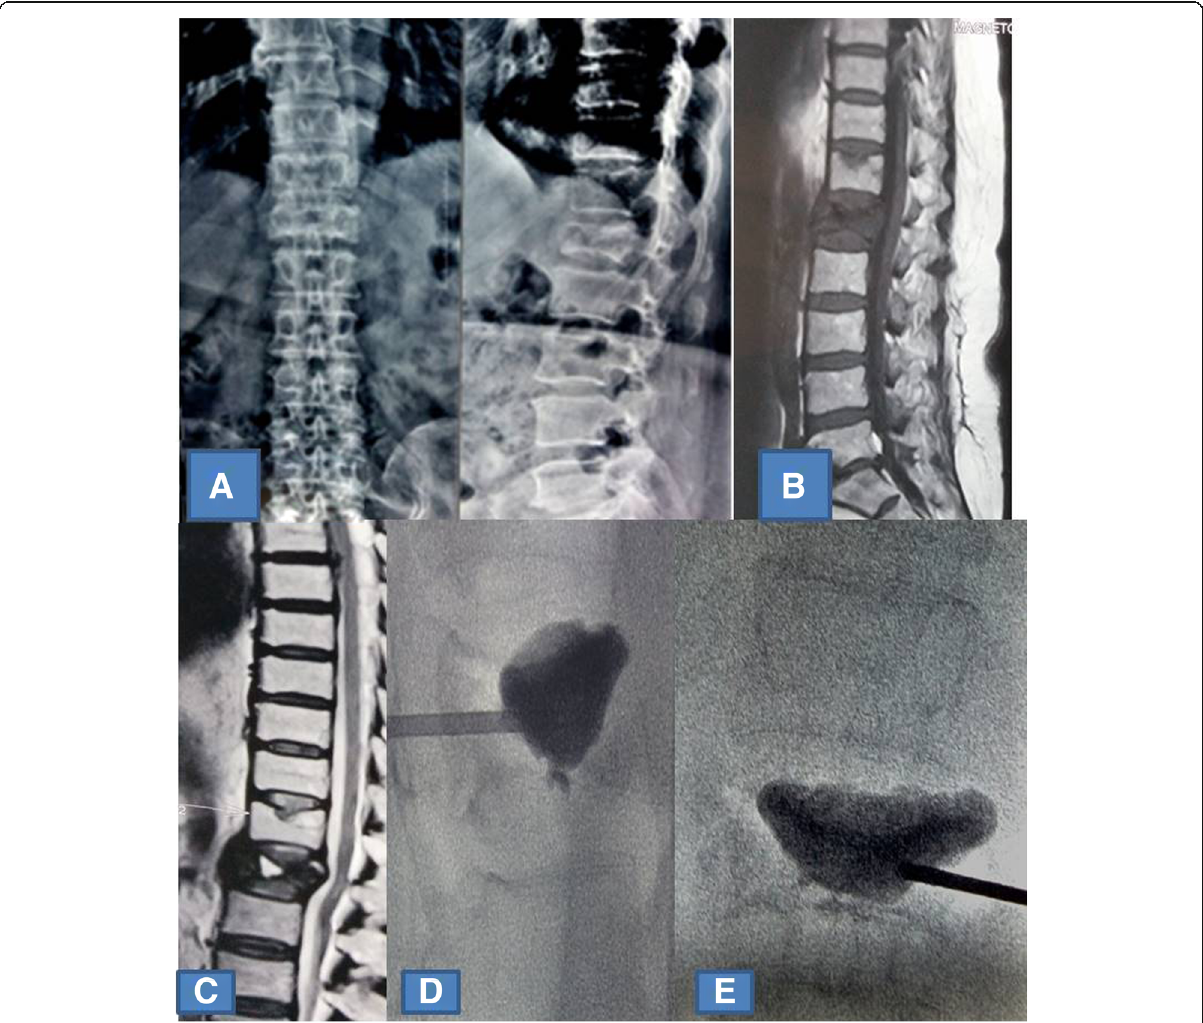
Fig. 7 A 65-year-old female with history of trauma 3 months back and had low back ache since then with difficulty in walking and tenderness at L1 and L2 vertebral level. She also had complaints of tingling and numbness in bilateral lower limb. a X-ray Thoracolumbar spine AP and lateral view showing post-traumatic collapse of L1 vertebra. b MRI T1 and c MRI T2WI showing collapse of L1 with adjacent bone edema and thecal